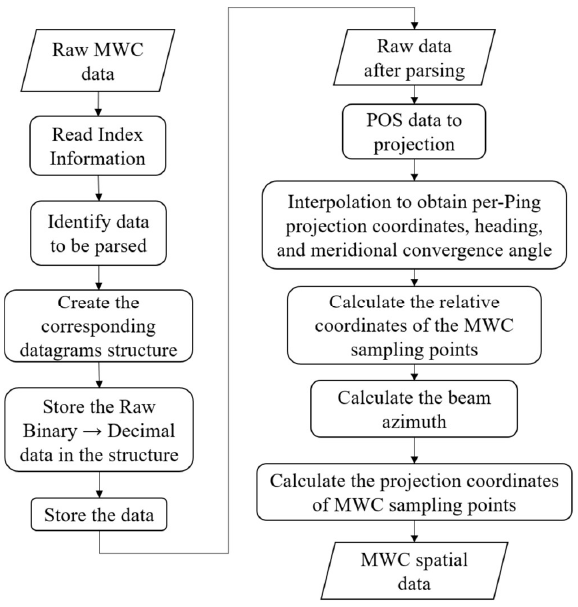
Figure 3. Spatial analysis and locating calculation process of MWC sampling points.